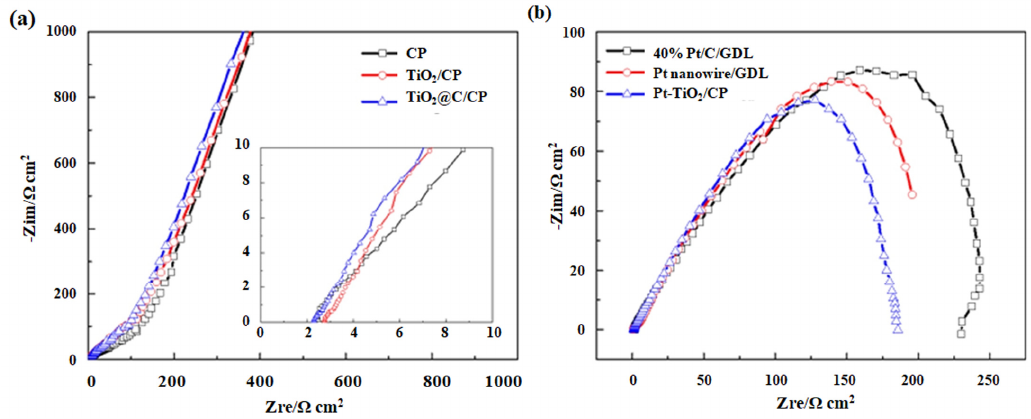
Figure 5. EIS plots of the CP, TiO 2 /CP, and TiO 2 @C/CP ( a ) and Pt/C, Pt nanowire/GDL, and Pt-TiO 2 @C/CP ( b